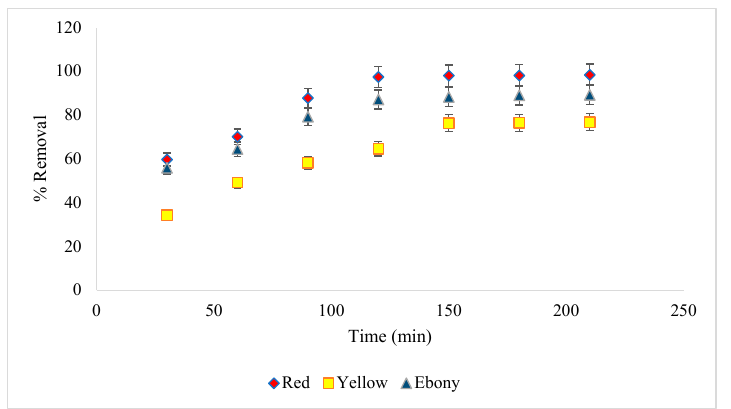
Figure 5. Effect of contact time on the adsorption of hair dyes [dosage = 0.07 g R, 0.06 g Y, & 0.05 E, time = 20–210 min, C i = 50 mg·L − 1 ; pH = 7.0, and T = 25 ± 1 °C, speed = 150 rpm].